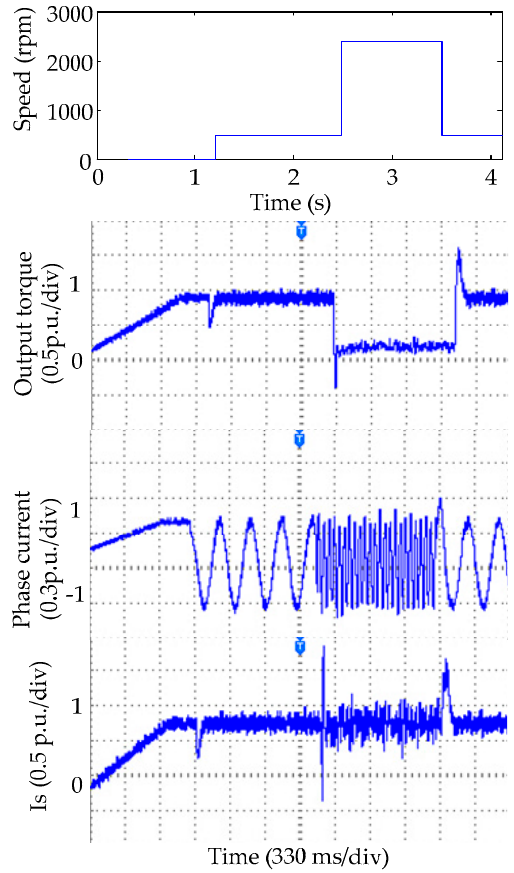
Figure 17. Dynamic response to speed reference step variation with the proposed control strategy when torque command is 200 nm.